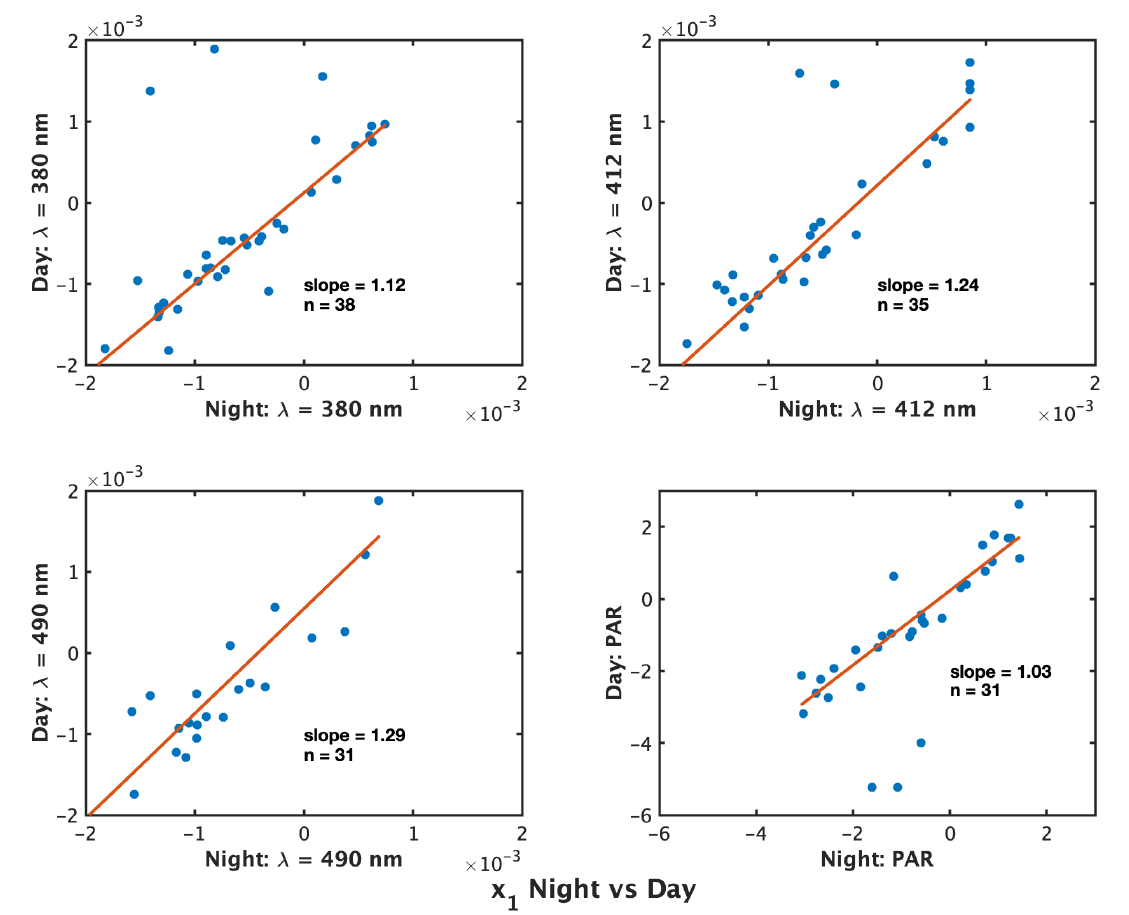
Figure 4. Comparison of x 1 by obtained from nighttime profiles ( x -axis) and daytime profiles ( y -axis) both methods. Results for λ = 380 nm ( top left ), 412 nm ( top right ), 490 nm ( bottom left ), and PAR ( bottom right ). Table 2. Absolute size of corrections applied by both methods on good profiles at all